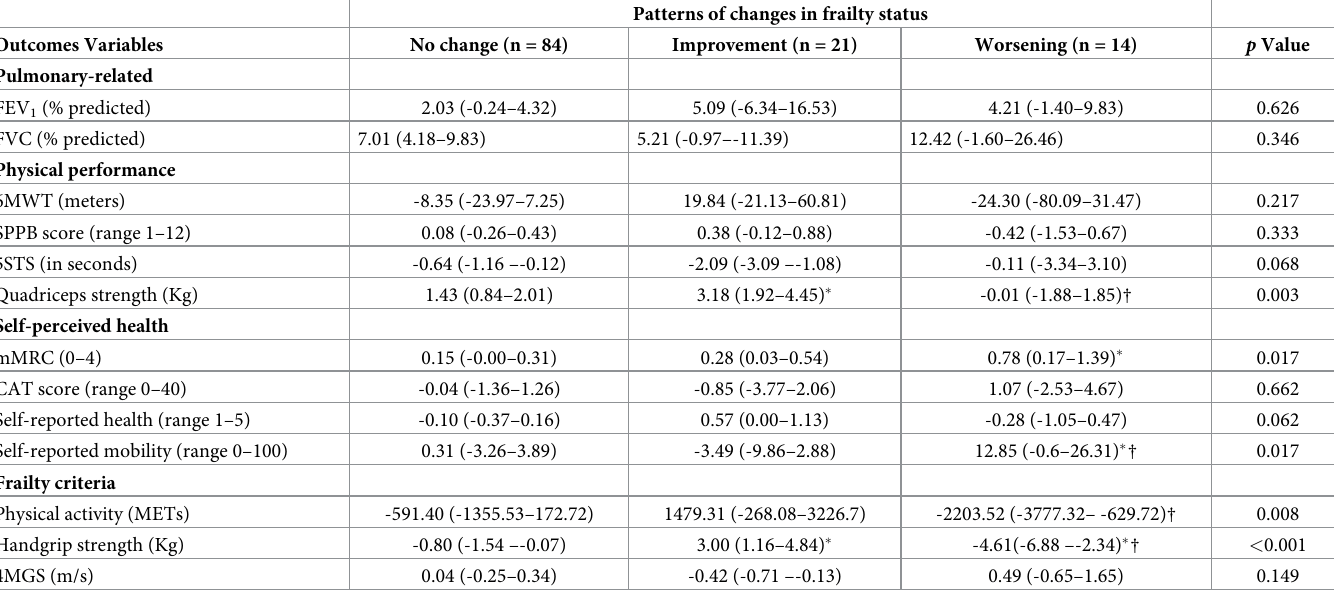
Table 2. Comparison of clinical outcomes following 2-years according to changes in frailty status (n = 119).